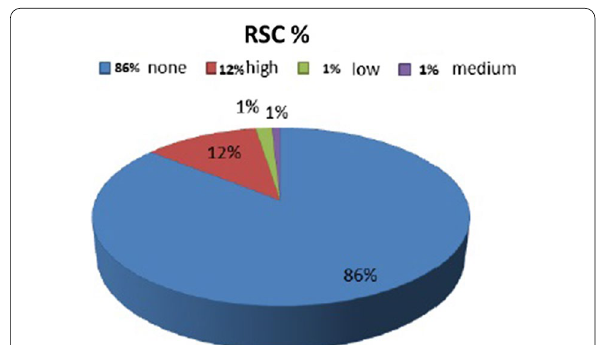
Fig. 13 Groundwater classes according to the percentage of RSC in the available groundwater